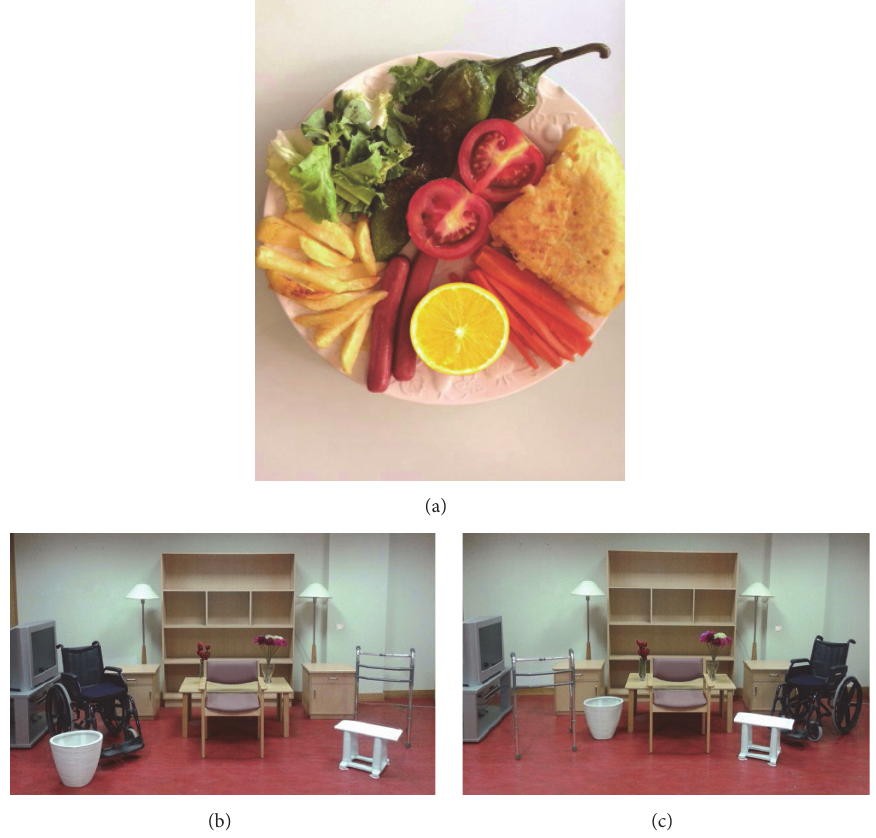
Figure 1: Picture scanning test. Adaptation to the Spanish population (authorized by Pearson